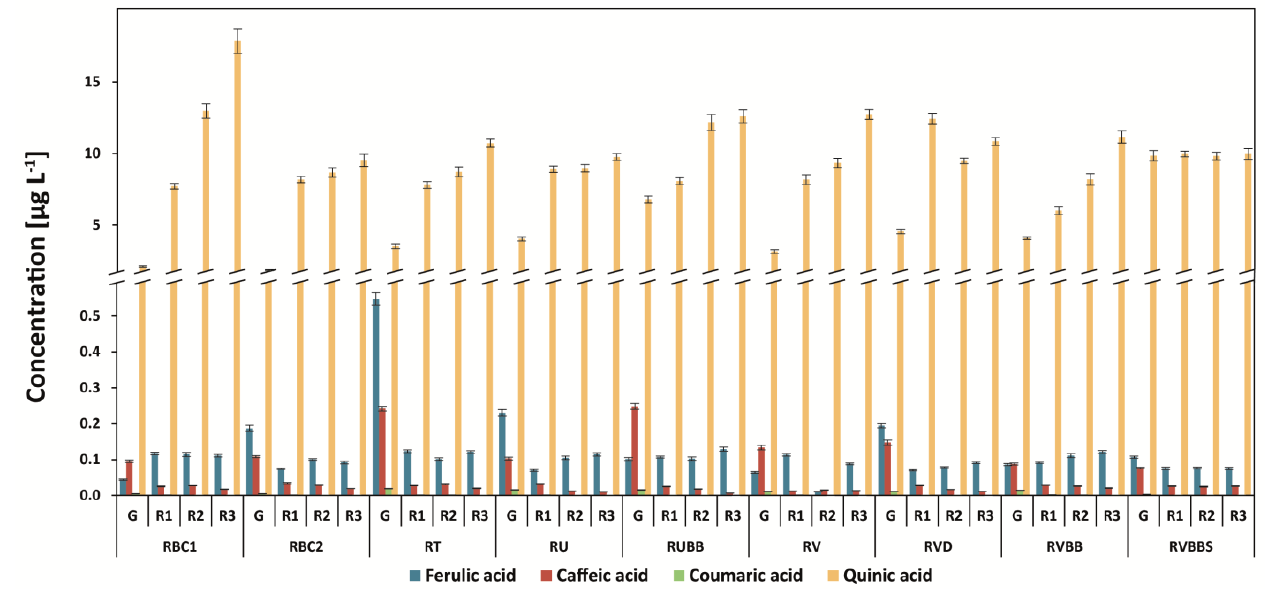
Figure 8. Ferulic, caffeic, p -coumaric, and quinic acids in Robusta coffee brews. Legend — Figure 1